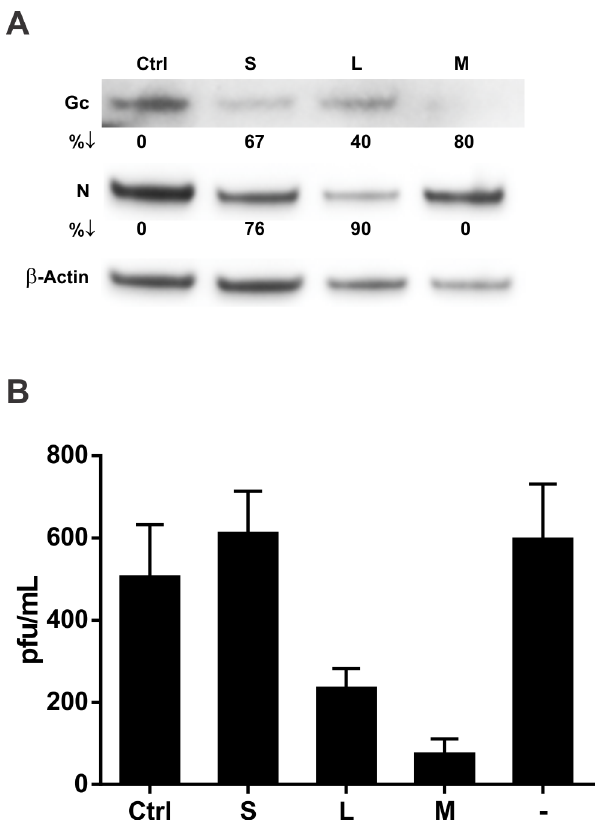
Figure 4. siRNA inhibits ANDV replication in human primary lung endothelial cells (HMVEC-L). HMVEC-L were transfected with siRNAs for 6 h, and then infected with ANDV at MOI =0.5. After 2 h of virus adsorption, the virus inoculum was removed and replaced with fresh media. (A) Viral protein levels as determined by Western blotting. Percent downregulation (% Q ) of N or Gc protein represents percent decrease compared to non-targeting siRNA control. (B) Viral production as measured by immunofocus assays 48 h